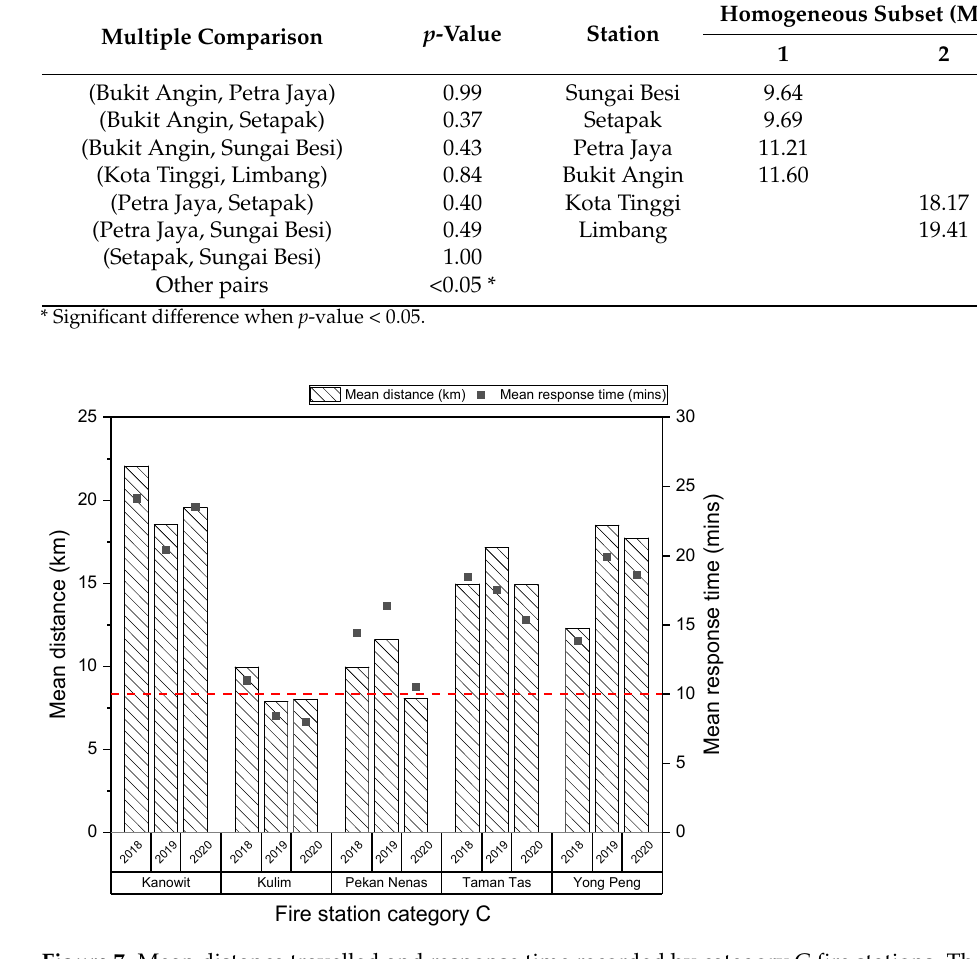
Figure 7. Mean distance travelled and response time recorded by category C fire stations. The red dash line is the mean response time benchmark for Malaysia.